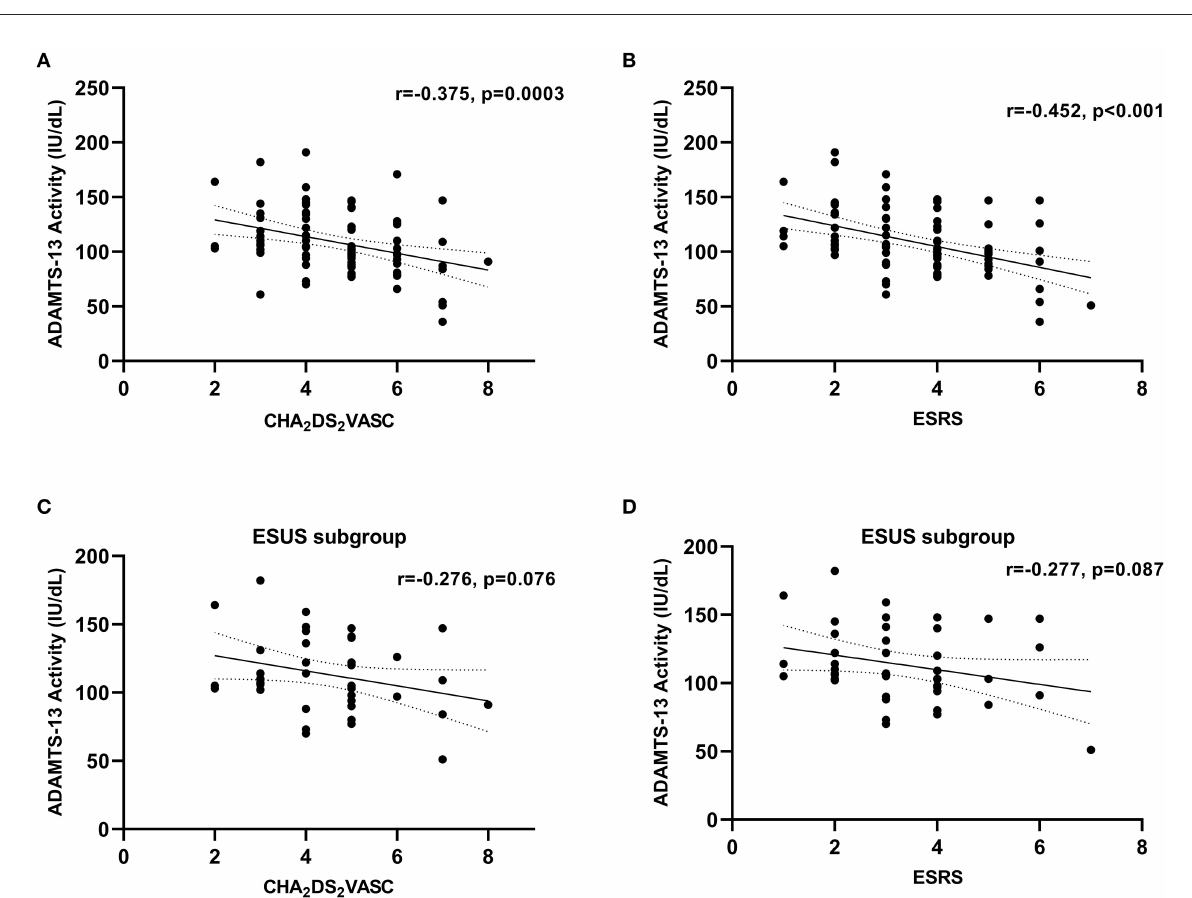
FIGURE2 Correlation between ADAMTS-13 activity and vascular risk factors in cohort 1. (A) Whole cohort 1, CHA 2 DS 2 VASC; (B) whole cohort 1, ESRS; (C) ESUS subgroup, CHA 2 DS 2 VASC; (D) ESUS subgroup, ESRS. Correlation coefficients were calculated using Spearman’s rank